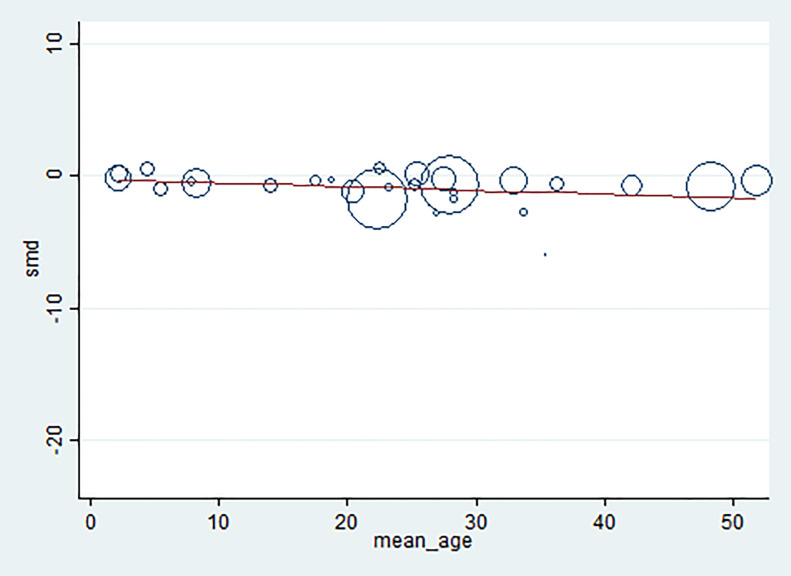
Meta-regression graph of mean age as a covariate.